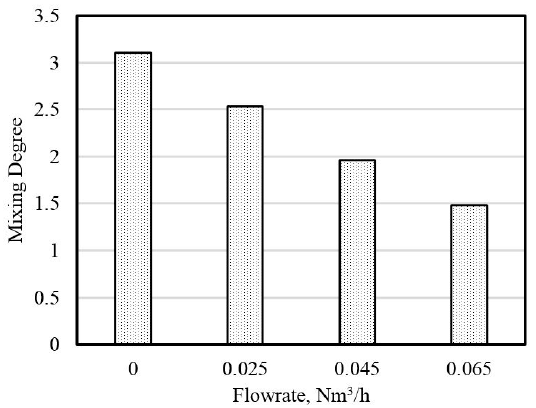
Figure 12. Mixing degree as a function of bottom blowing flowrate at a bath depth of 500 mm.